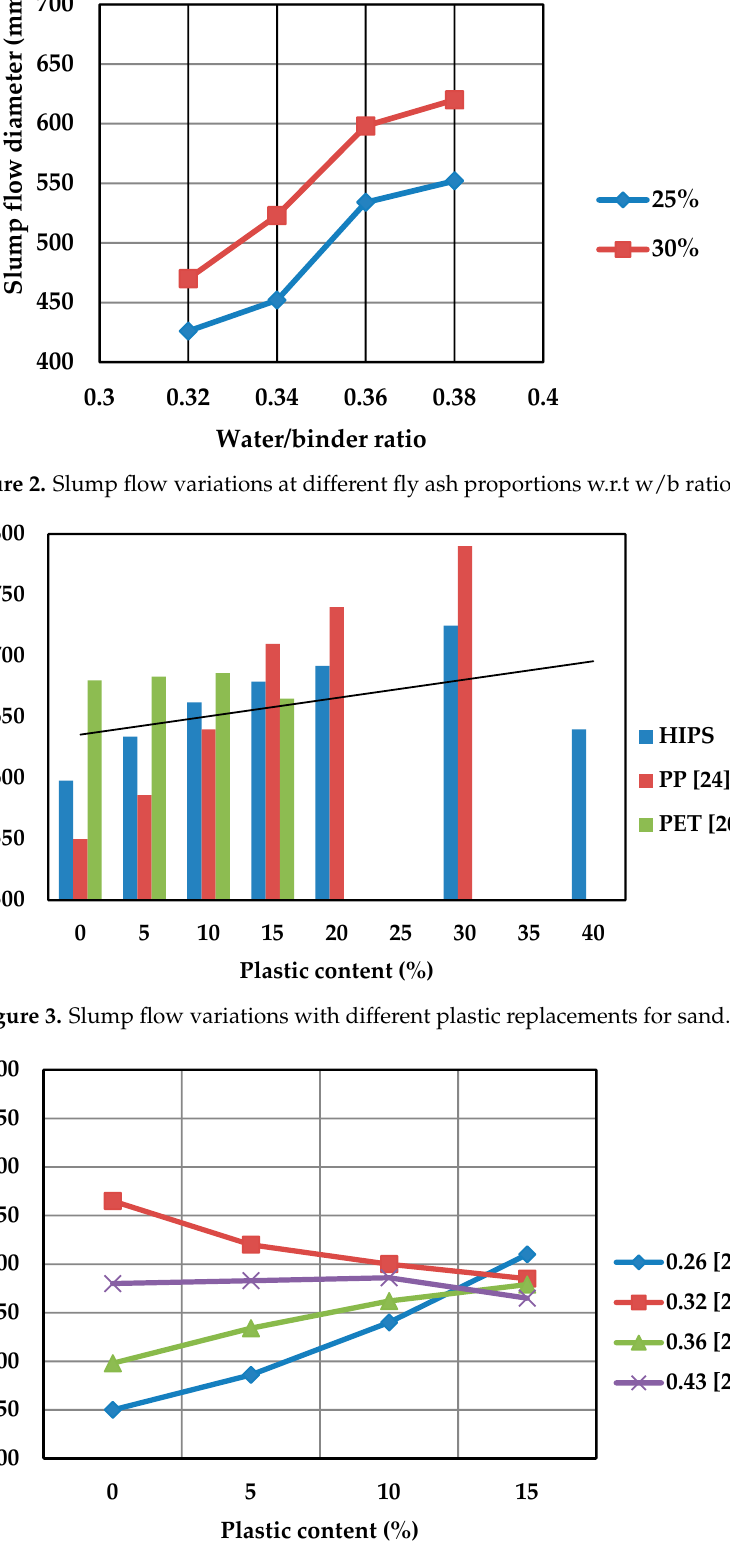
Figure 4. Slump flow variations with different w/c ratios. 204